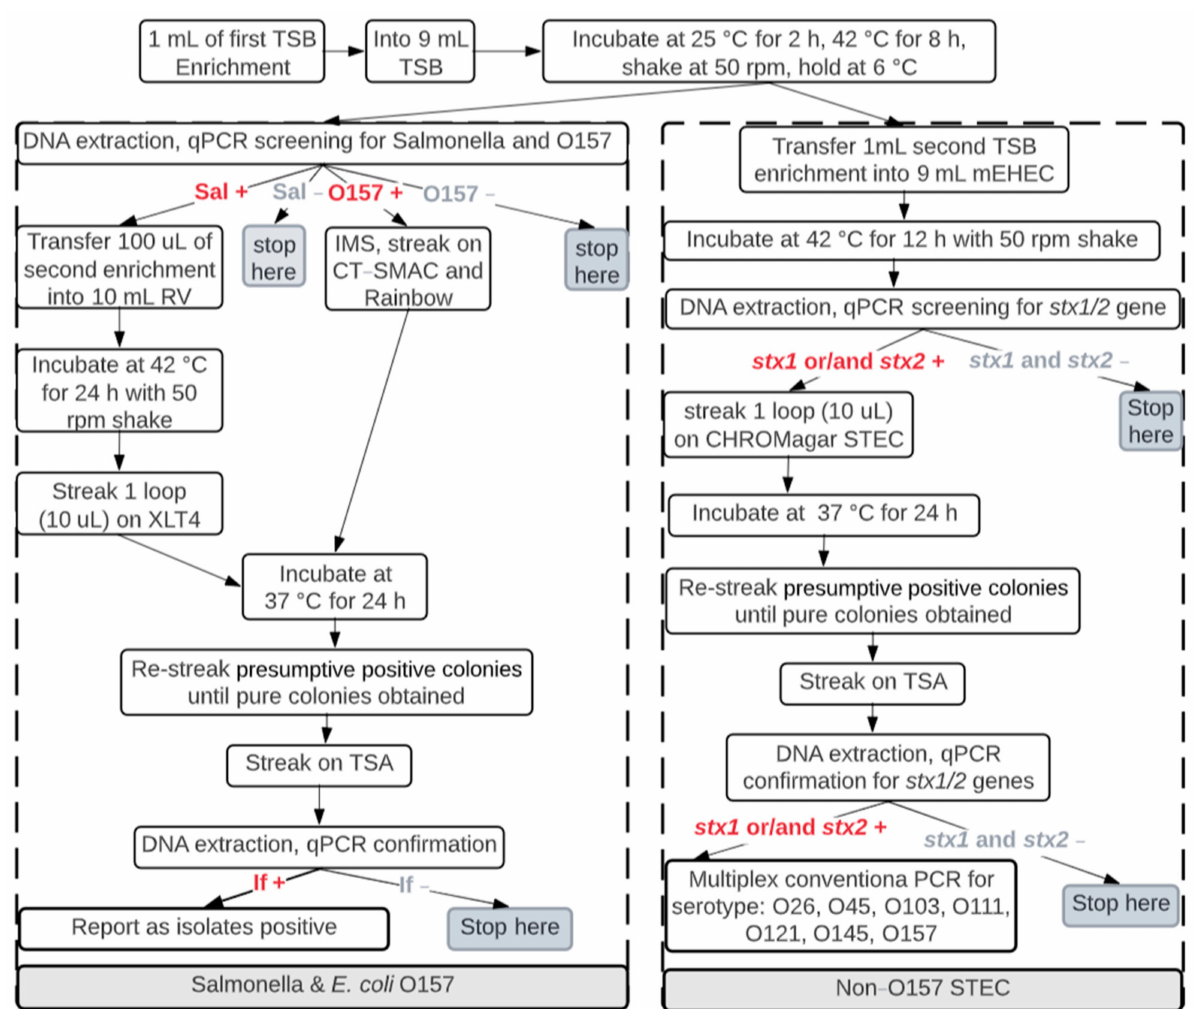
Figure 4. The flowchart for pathogen detection from enrichments ( E. coli O157:H7, STEC,